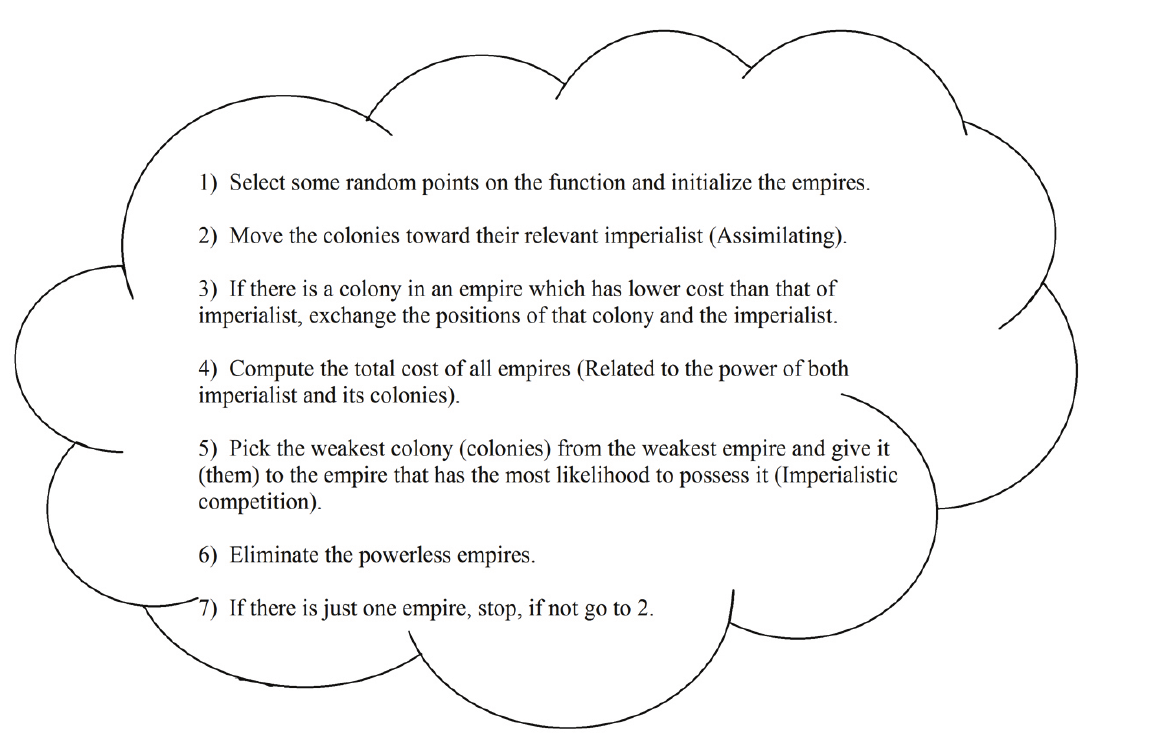
Figure 8. Pseudo code of the Imperialistic Competitive